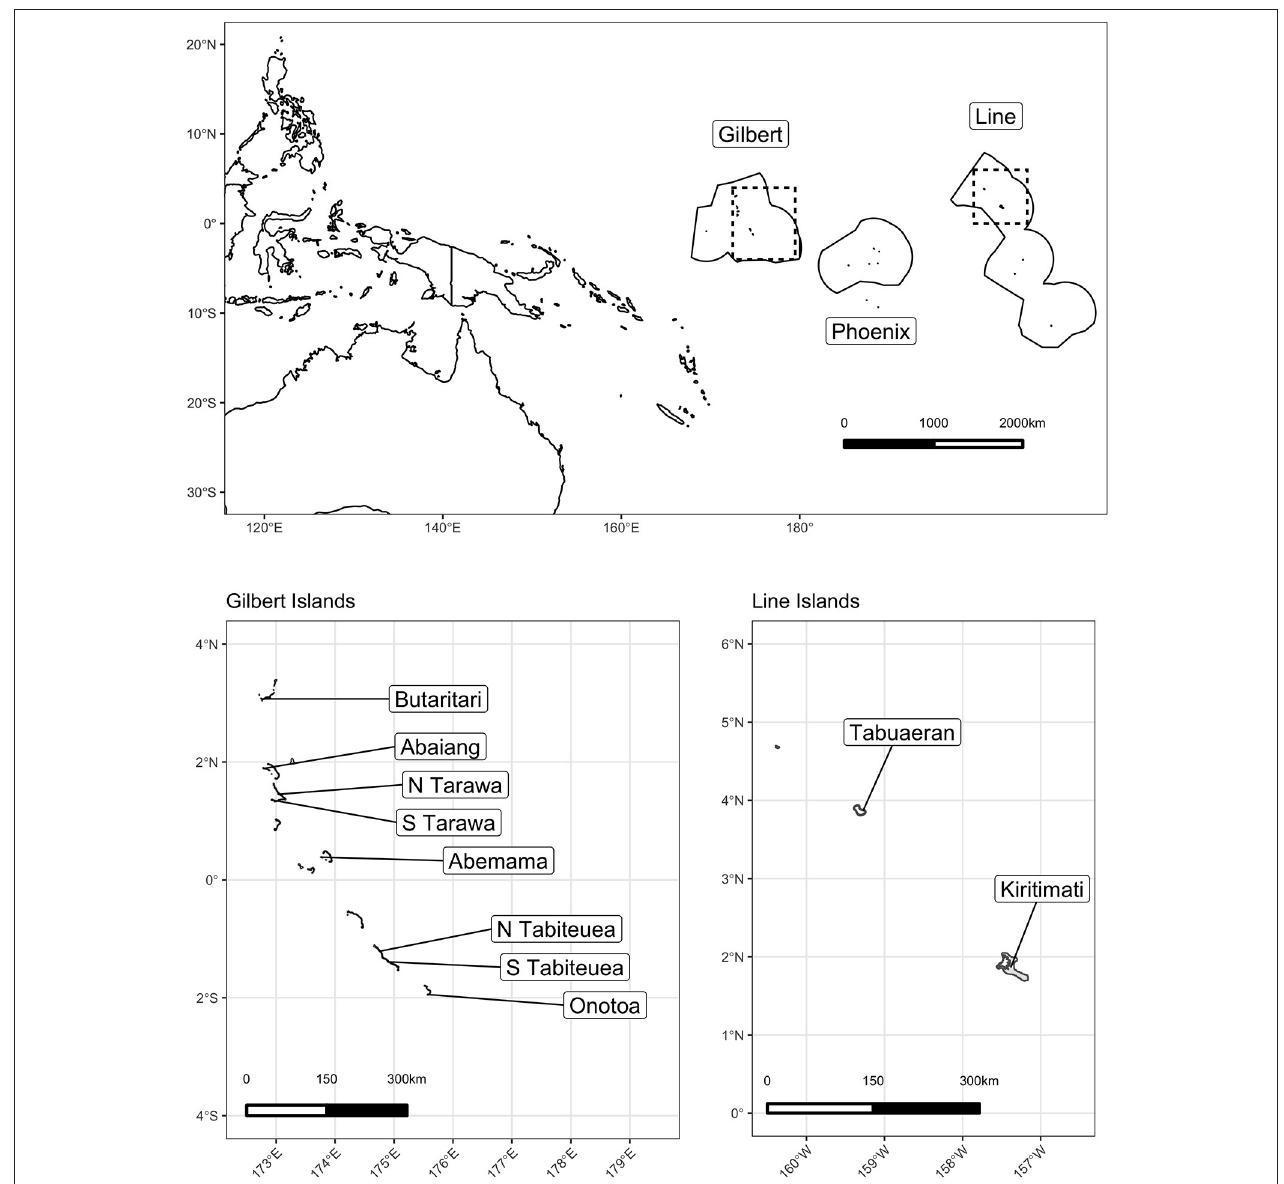
FIGURE 1 | Map of the study area in the Republic of Kiribati.